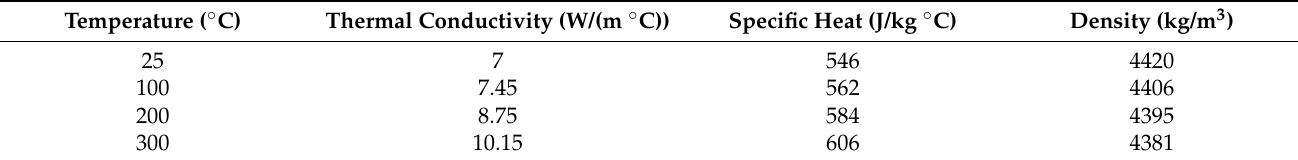
Table 2. Physical properties of Ti-6Al-4V with temperature [36].